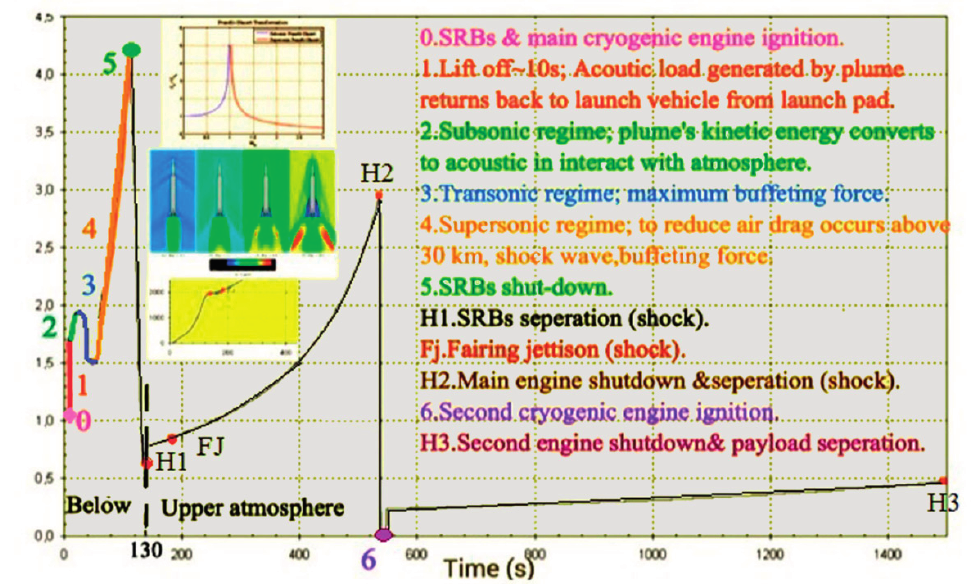
Figure 6. Sequence of events on the trajectory (SBR = Solid Rocket